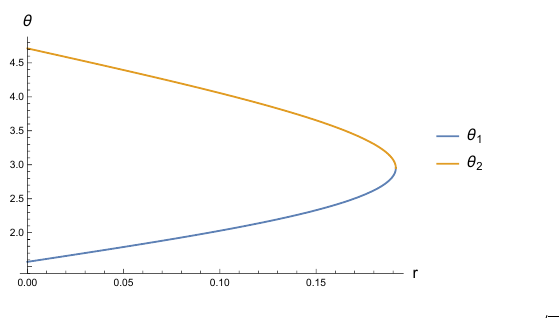
Figure 2. Graphs of θ 1 and θ 2 against r : for each value of r < r max ≡ the endpoints of the angular interval on the fixed circle which exhibits thermal order in the second sector. They always lie in the regime π